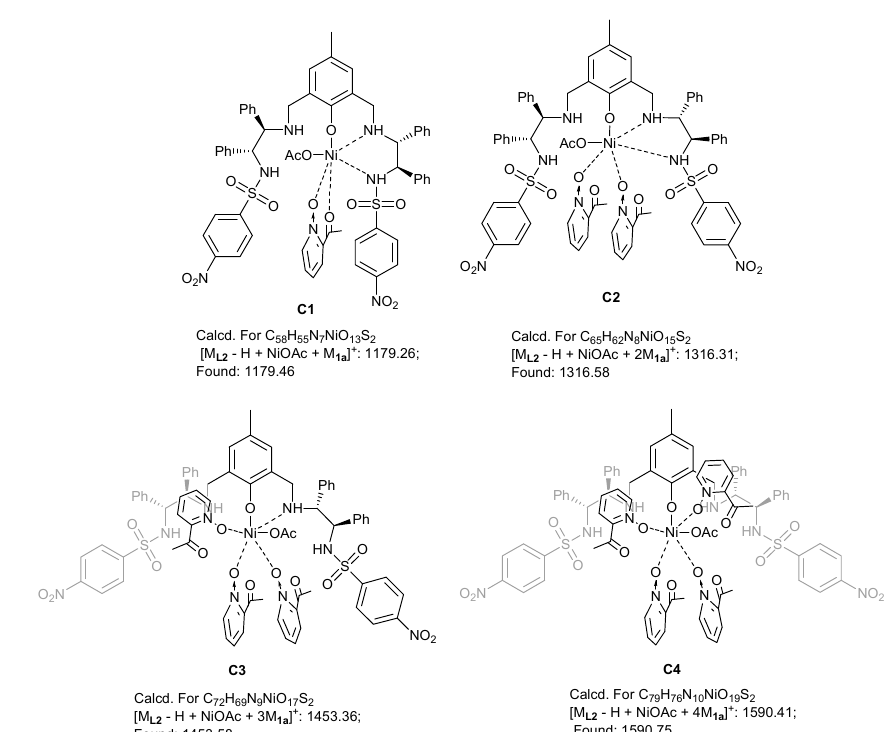
Figure 3. The speculated structures of Ni/ L2 / 1a according to the ESI-MS analysis.